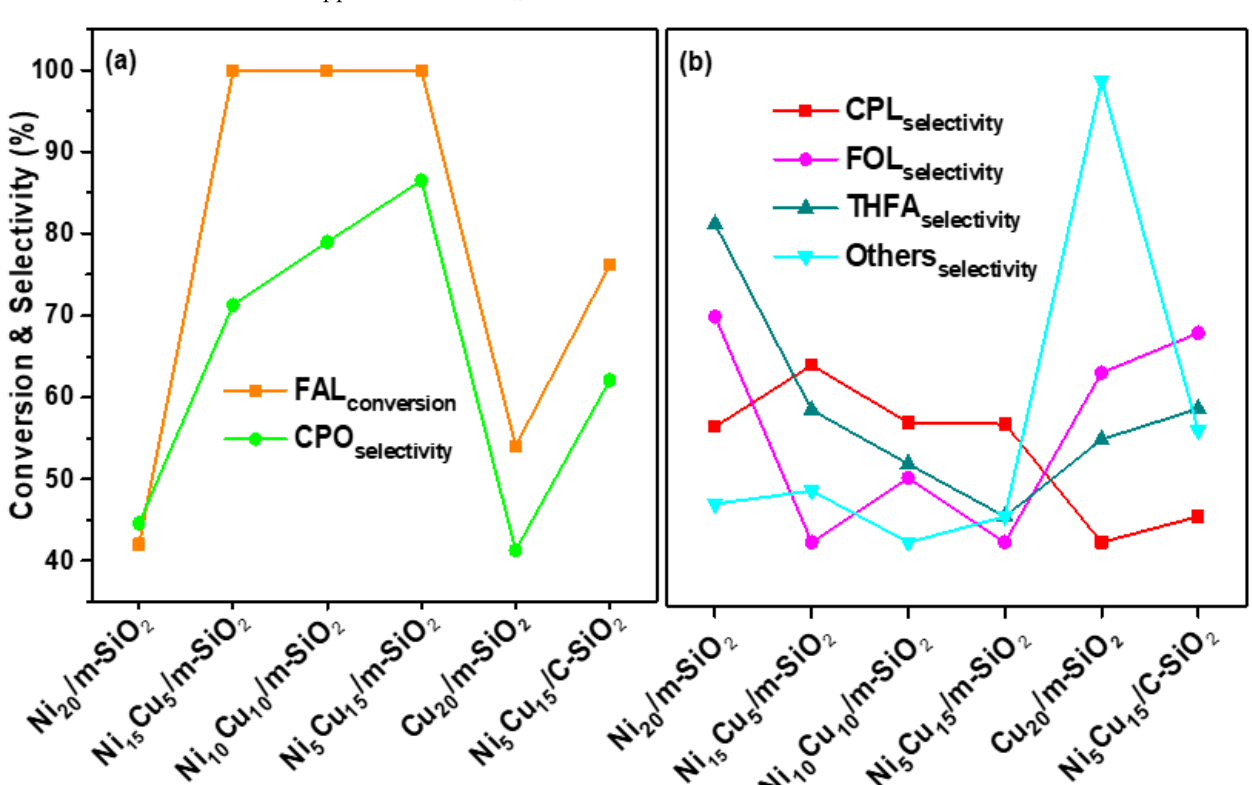
Figure 7. Catalytic performance in furfural (FAL) hydrogenation over metals supported on m-SiO 2 . Reaction condition: 5.2 mmol FAL, 15 mL water, catalyst 0.17 g, 140 °C, 3 MPa H 2 , 4 h and. See Scheme 1 for product details. ( a ) Conversion of FAL & Selectivity of CPO, ( b ) Selectivity of other products.